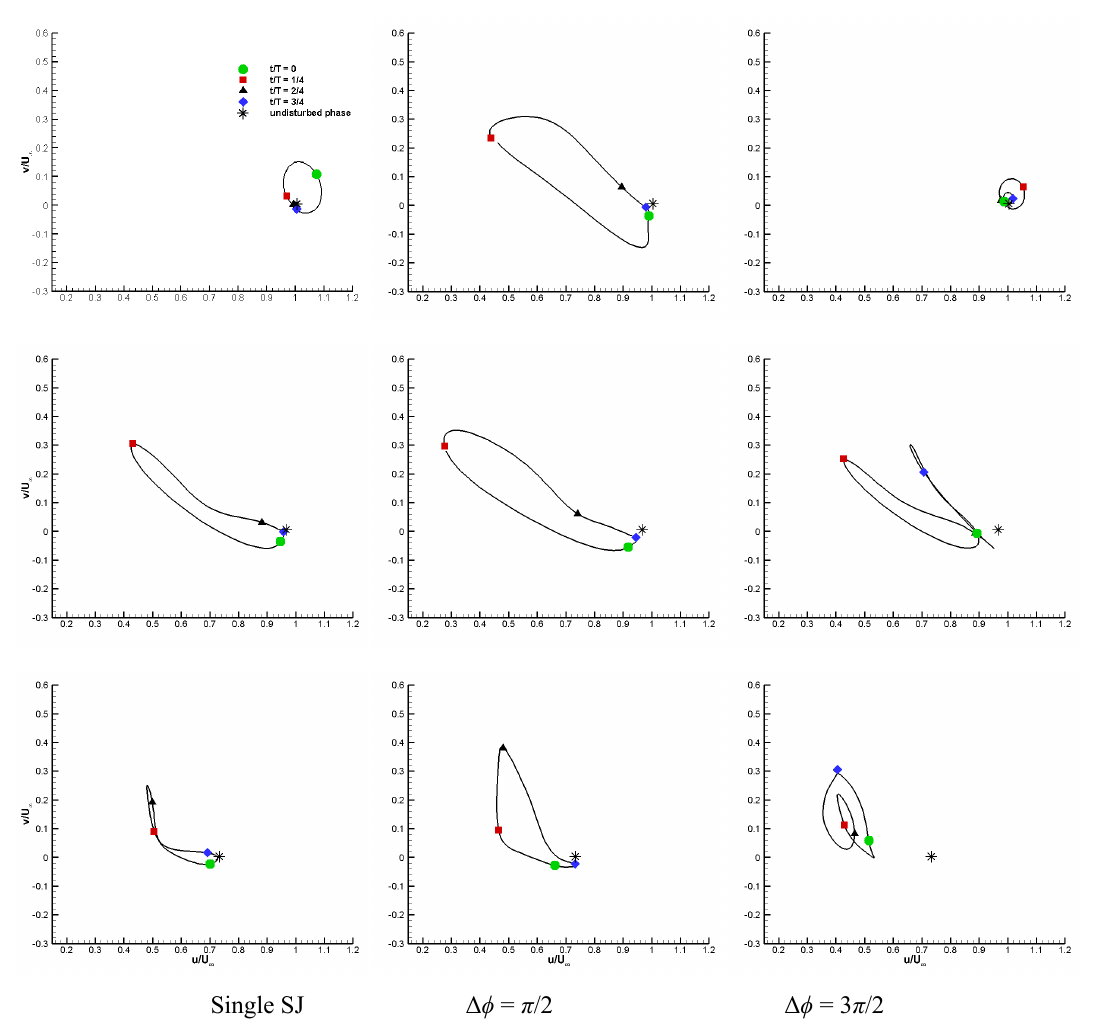
Figure 10. Correlations of streamwise and wall-normal velocity components in the mid-span plane at three selected positions, top: ( x = 5 D o , y = 3.4 D o ), middle: ( x = 5 D o , y = 2.4 D o ), bottum: ( x = 5 D o , y = 1.4 D o